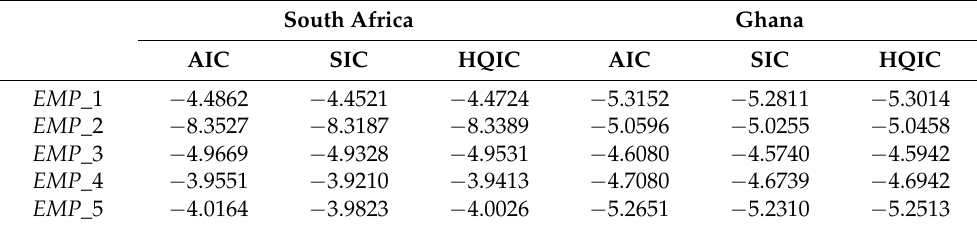
Table A3. Information criterion for selecting the best index for South Africa and Ghana.